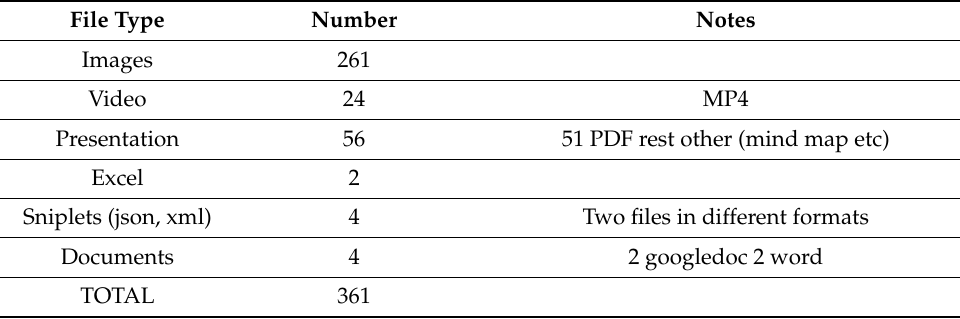
Table A3. Number and Type of File